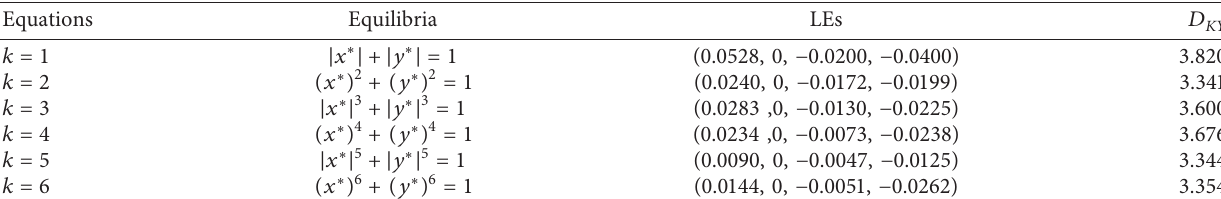
Table 1: Lyapunov exponents of different integers k